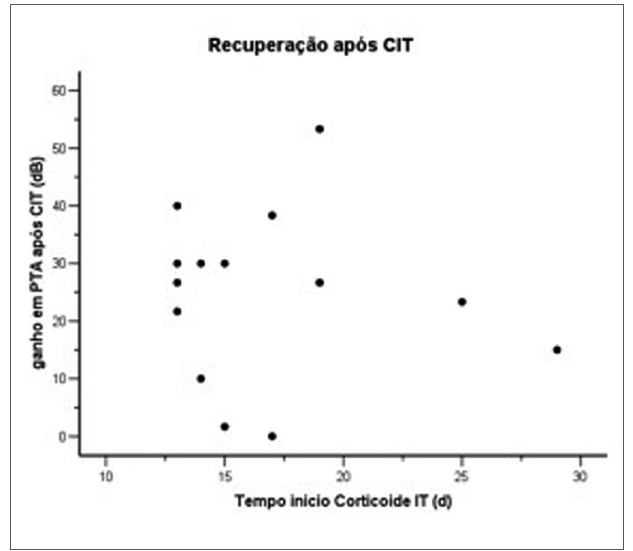
Figura 3. Relação da Recuperação após CIT e Tempo de Início da Corticoterapia.